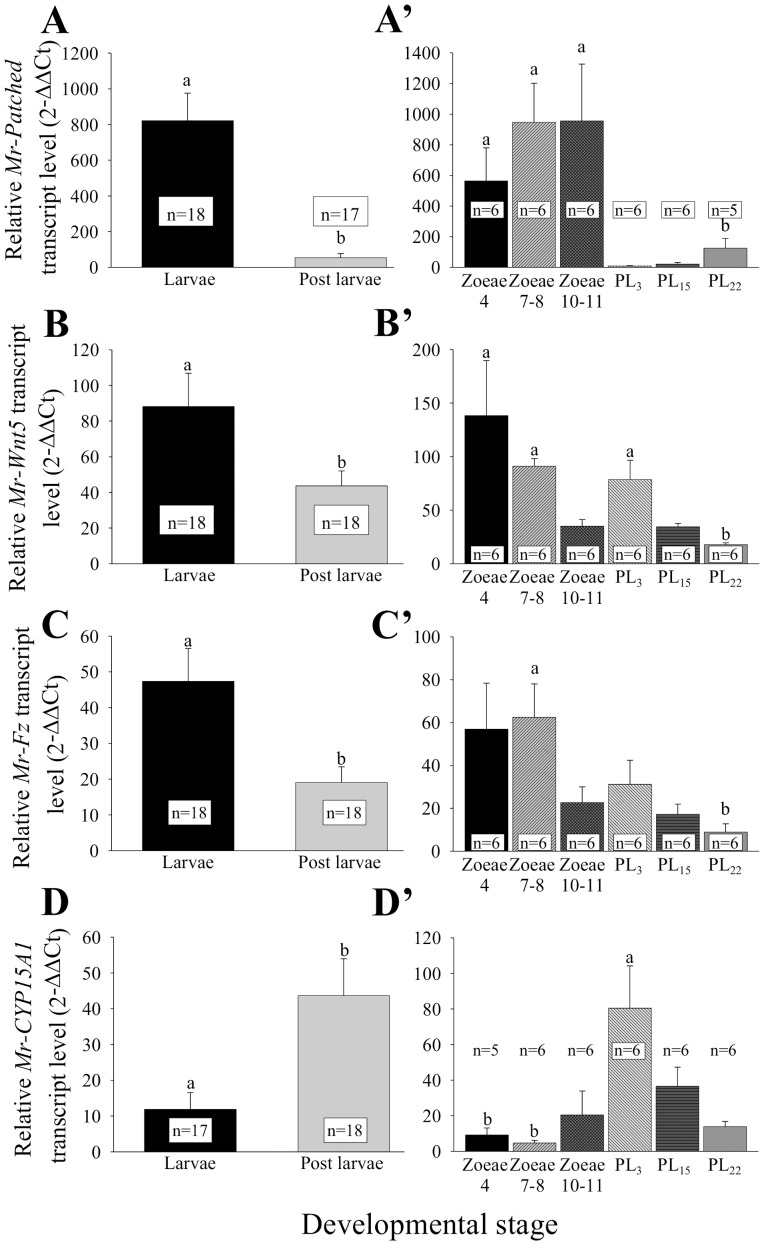
Relative transcript levels of key metamorphosis-related genes.Relative transcript levels of Mr-Patched, Mr-Wnt5, Mr-Fz and Mr-CYP15A1 were quantified via real-time RT-PCR in larvae and PLs (n = 18 in each group). Different letters represent significant differences, while error bars represent SEM. Comparison of relative Mr-Patched (A), Mr-Wnt5 (B) and Mr-Fz (C) transcript levels in larvae and PLs reveals a highly significant difference (Mann-Whitney U test, P-value <0.01), supporting the ratio of ∼20 (Mr-Patched) and ∼2 (Mr-Wnt5 and Mr-Fz) in favor of the larval group compared with PLs, as calculated by the RPM ratio obtained with the transcriptome. Comparison of relative Mr-CYP15A1 (D) transcript levels in larvae and PLs also reveals a highly significant difference (Mann-Whitney U test, P-value <0.01), supporting the higher expression levels expected in PLs, as calculated by the RPM ratio obtained with the transcriptome. However, when dividing the larval and PL groups into defined stages (Zoea 4, 7–8, 10–11, PL3, 15, 22), the overall trend is more complex, with significantly higher Mr-Patched transcript levels seen in Zoea 4, and 7–8, as compared with PL15 and PL22 and also in Zoea 10–11, as compared with PL22 (A'; Kruskal-Wallis test: H (df = 5, N = 36)  = 24.06317, P-value <0.05), significantly higher Mr-Wnt5 transcript levels seen in Zoea 4, 7–8 and PL3, as compared with PL22 (B'; Kruskal-Wallis test: H (df = 5, N = 36)  = 28.50751, P-value <0.01), significantly higher Mr-Fz transcript levels in Zoea 7–8, as compared with PL22 (C'; Kruskal-Wallis test: H (df = 5, N = 36)  = 14.48048, P-value <0.02) and significantly higher Mr-CYP15A1 transcript levels in PL3, as compared with Zoea 4 and Zoea 7–8 (D'; Kruskal-Wallis test: H (df = 5, N = 36)  = 17.66032, P-value <0.05).